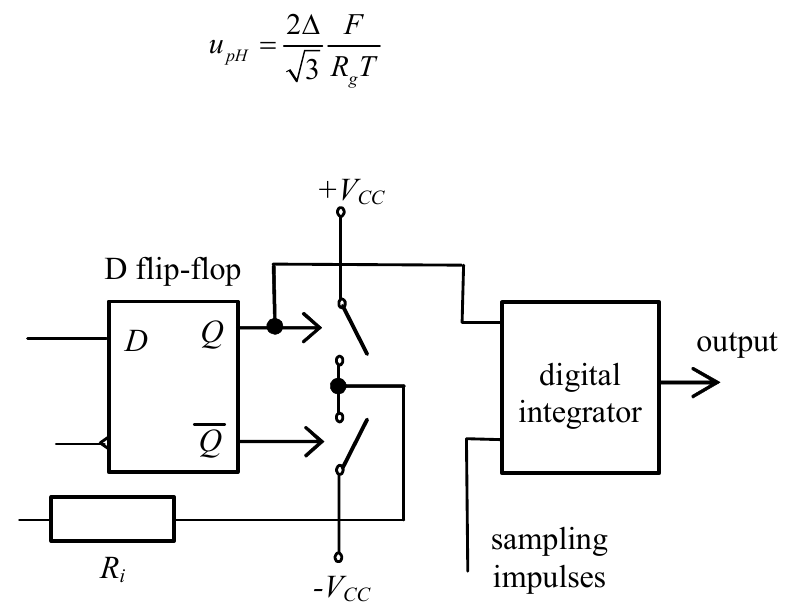
Figure 5. Processing the impulses by a digital